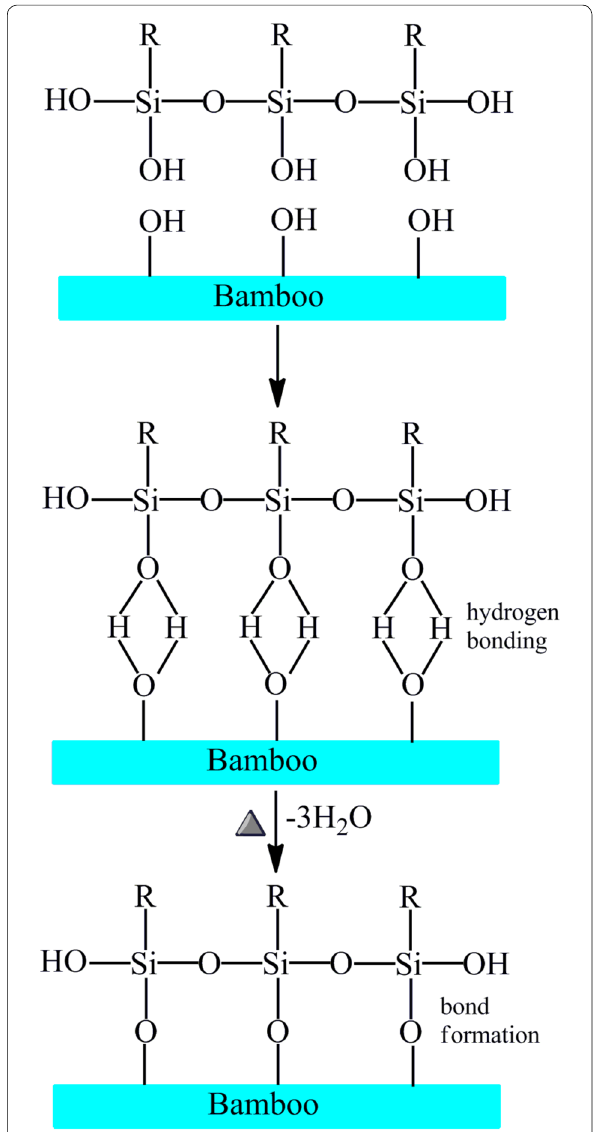
Fig. 7 Proposed deposition process of alkoxysilane on bamboo and hydrophobication–covalent bond formation in silanol groups of alkoxysilane, and hydrophobication